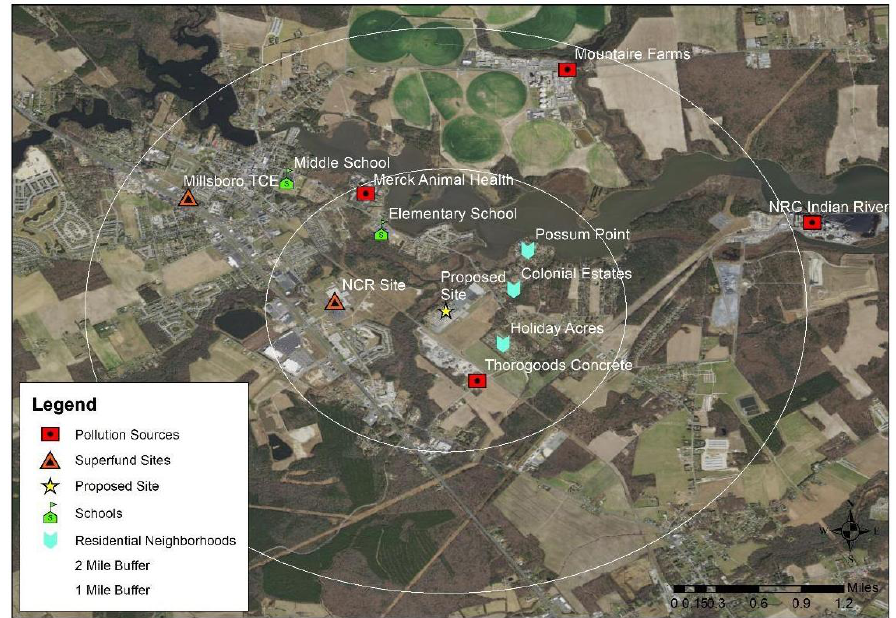
Figure 1. Map of Environmental Hazards Near the Millsboro Community.